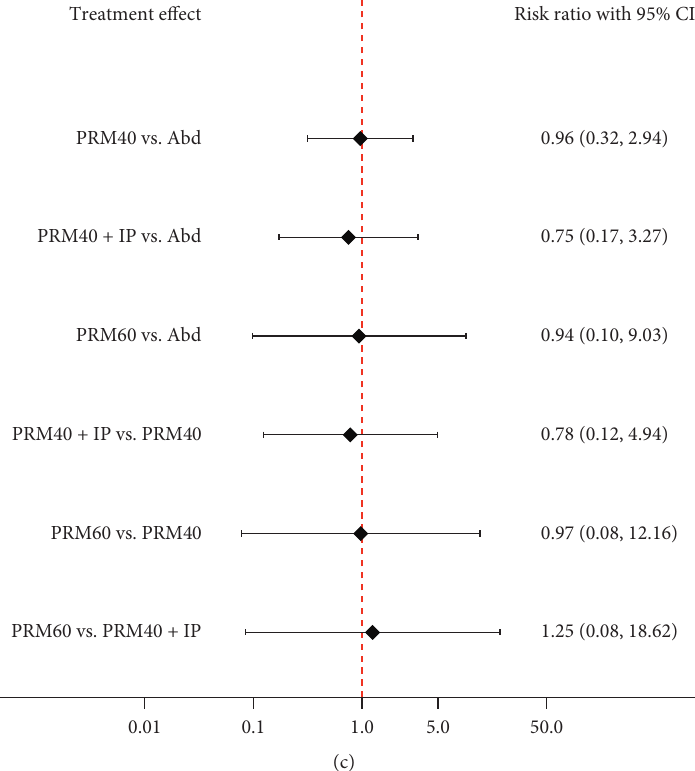
Figure 4: Network meta-analyses of adverse outcomes and the requirement of postoperative analgesia—risk ratio with 95% confidence interval. Abd: abdominal compression, PRM 40: pulmonary recruitment maneuver 40cm H 2 O, PRM 60: pulmonary recruitment maneuver 60cm H 2 O, IP saline: intraperitoneal saline, SUCRA: surface under the cumulative ranking curve. (a) Postoperative nausea/vomiting, (b) cardiopulmonary complications, and (c) requirement of postoperative